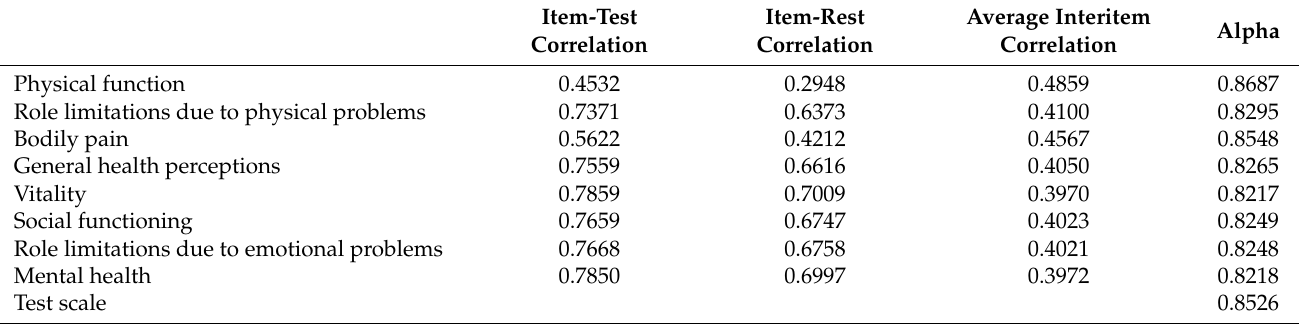
Table A3. The internal consistency for each of the eight SF-36 scales (Cronbach’s